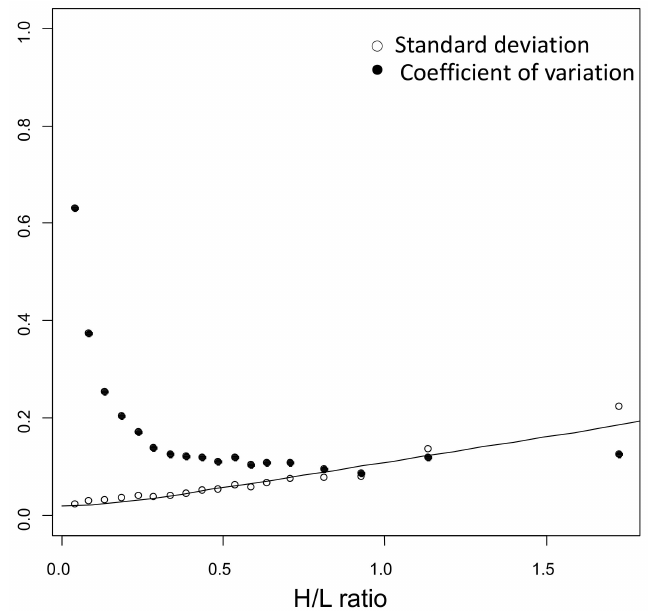
Figure 2. Model of technical variability. The standard deviation (SD, empty circles), and the coefficient of variation (CV, solid circles) are not constant with the average of the heavy to light ratio (H/L). (cid:113) α 2 + β 2 · r 2 was used to fit the standard deviation. The model was Therefore, the model SD = derived from replicated measurements of peptides.